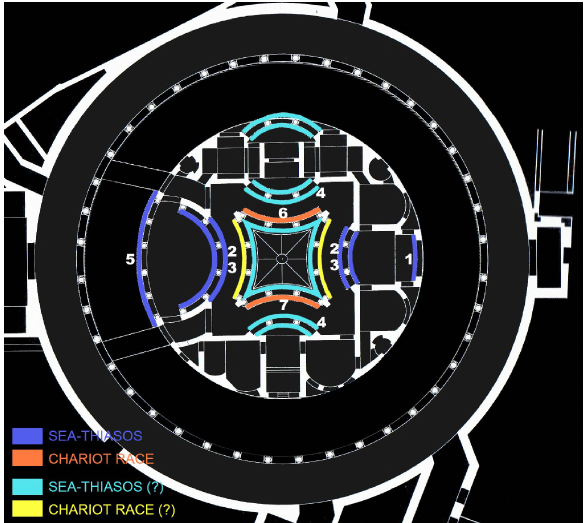
Figure 11. Üblacker’s hypothesis about the position of